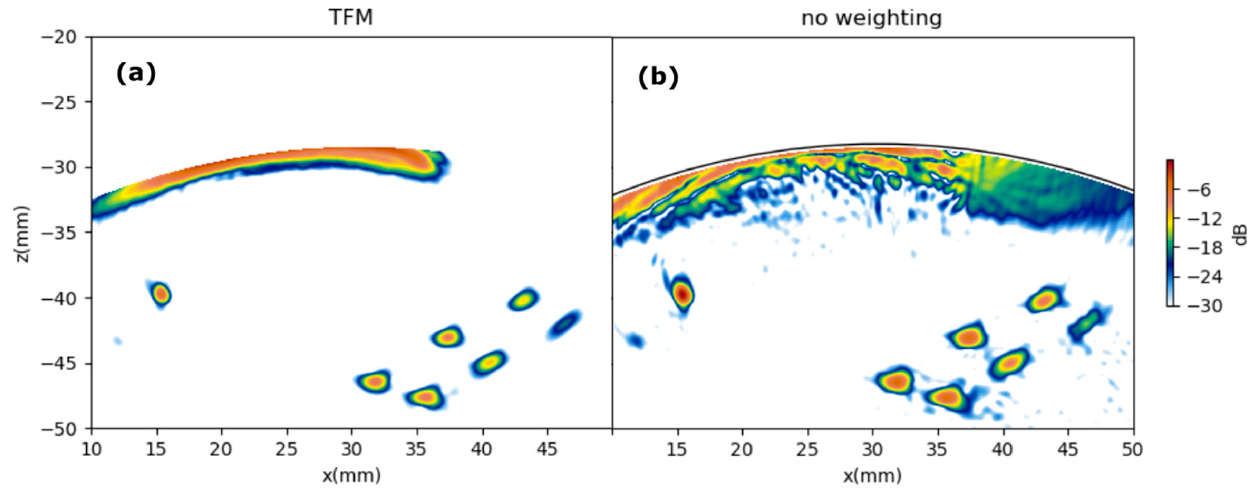
Figure 11. Simulation and partial PWI images for emission at − 30°, test piece B. ( a ) Simulated acoustic field, the dots represent the holes. ( b ) Partial PWI image. ( c ) Amplitude along green line in ( a ).